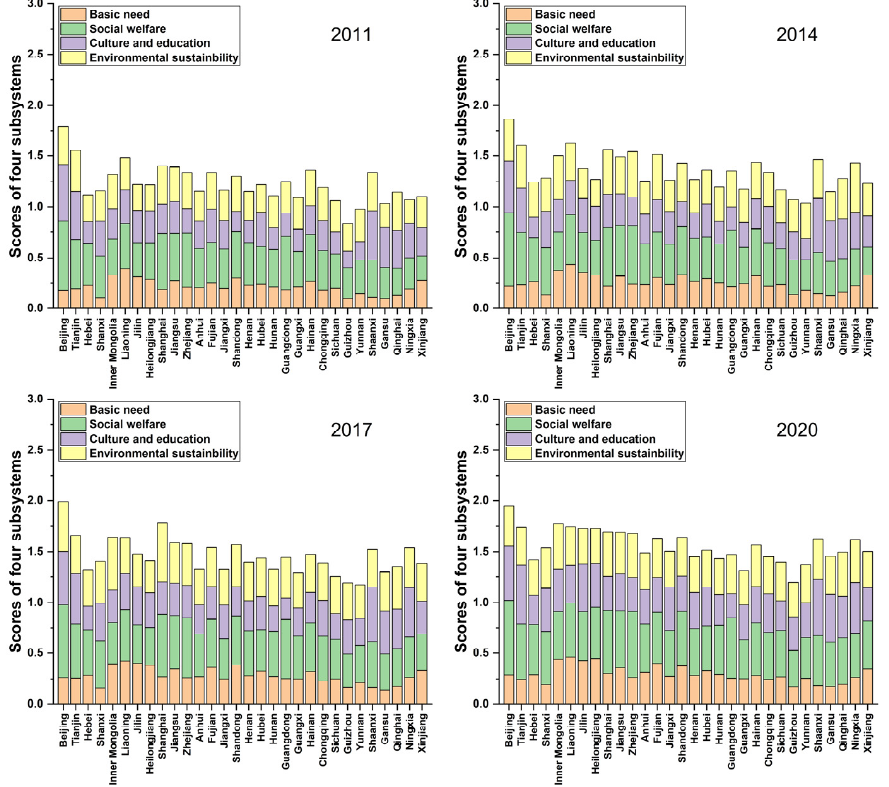
Figure 2. Scores of four subsystems in 2011, 2014, 2017, and 2020.